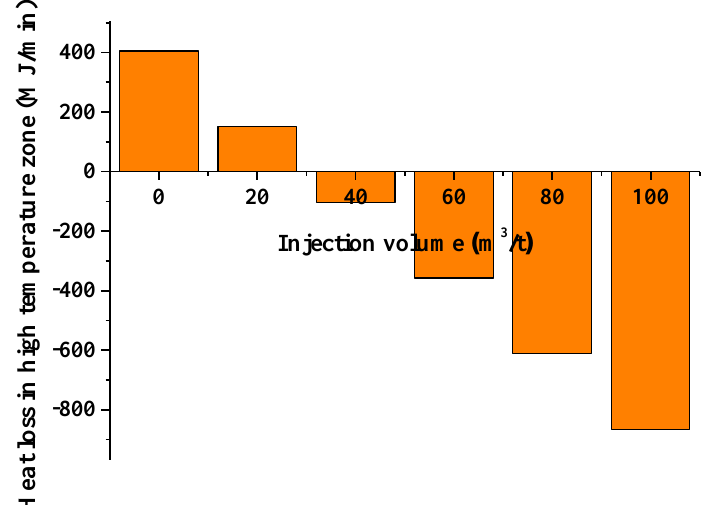
Figure 4. Effect of NG injection on heat loss in the high temperature zone.